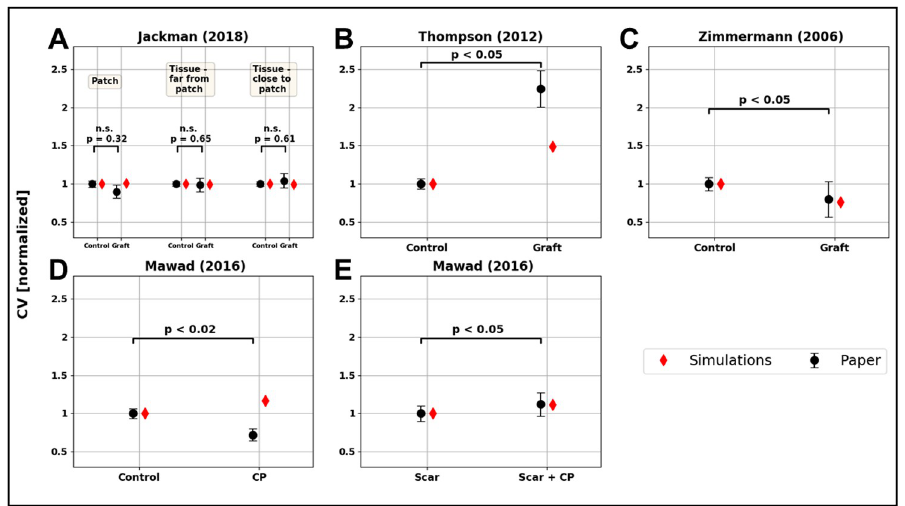
Fig 3. Results of the model validation. Experiments from 4 papers were compared to the model: Jackman et al (A), Thompson et al (B), Zimmermann et al (C) and Mawad et al (D-E). In panel A CV is evaluated in 3 different areas: on the patch, on the tissue far from the patch and on the tissue under the patch. In all 3 experiments, CV before (control) and after (graft) the attachment of the patch is compared. The CV measured experimentally (mean and standard deviation) are represented as black dots with error bars, with the p-values associated with each experiment. The simulated CV are displayed as red diamonds.